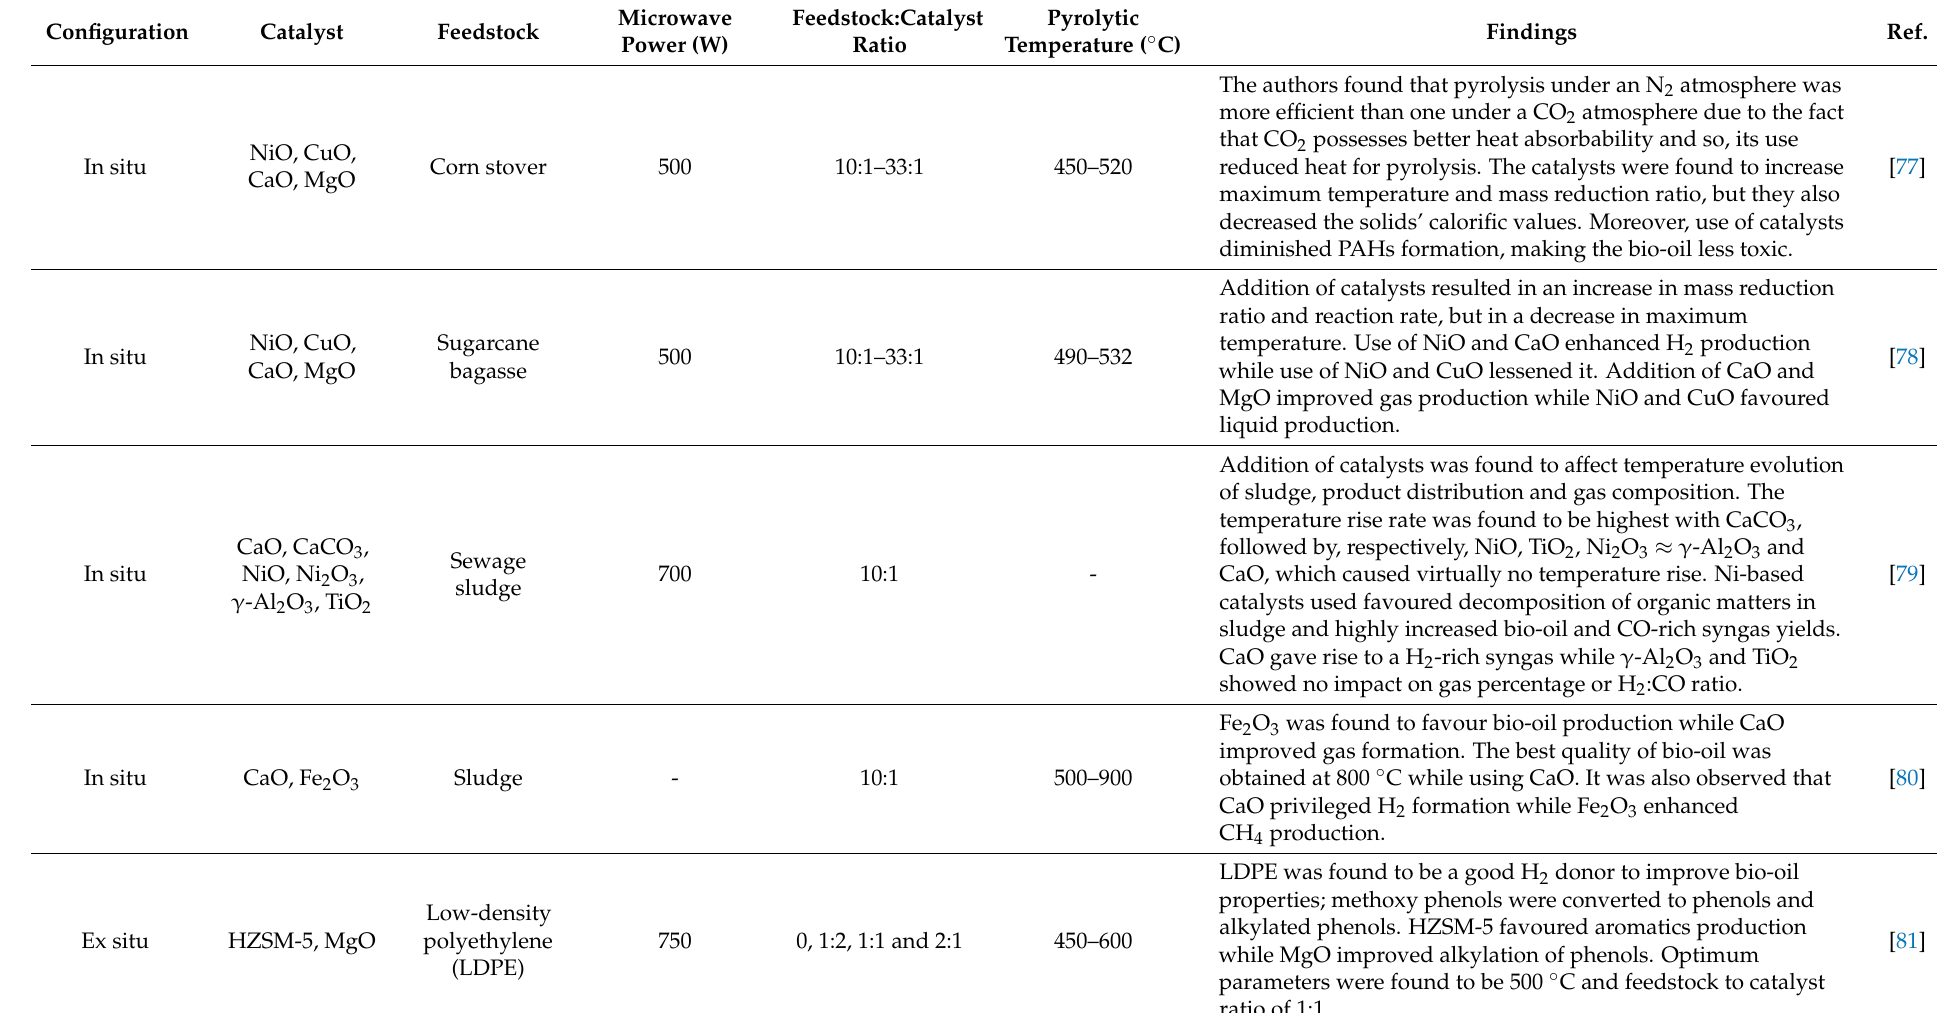
Table 7. Notable works on MAP using metal oxides as